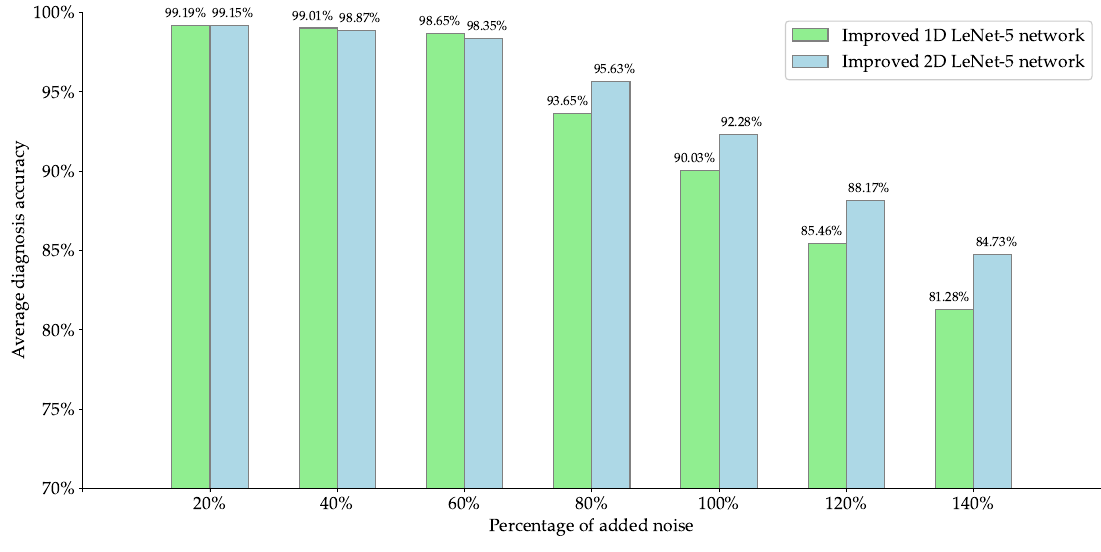
Figure 15. Comparison of fault diagnosis accuracy of improved 1D LeNet-5 network and improved 2D LeNet-5 network under noise